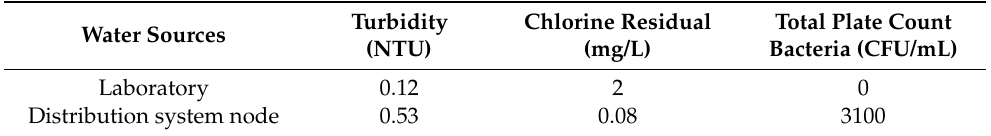
Table 1. Characteristics of the soaking water.